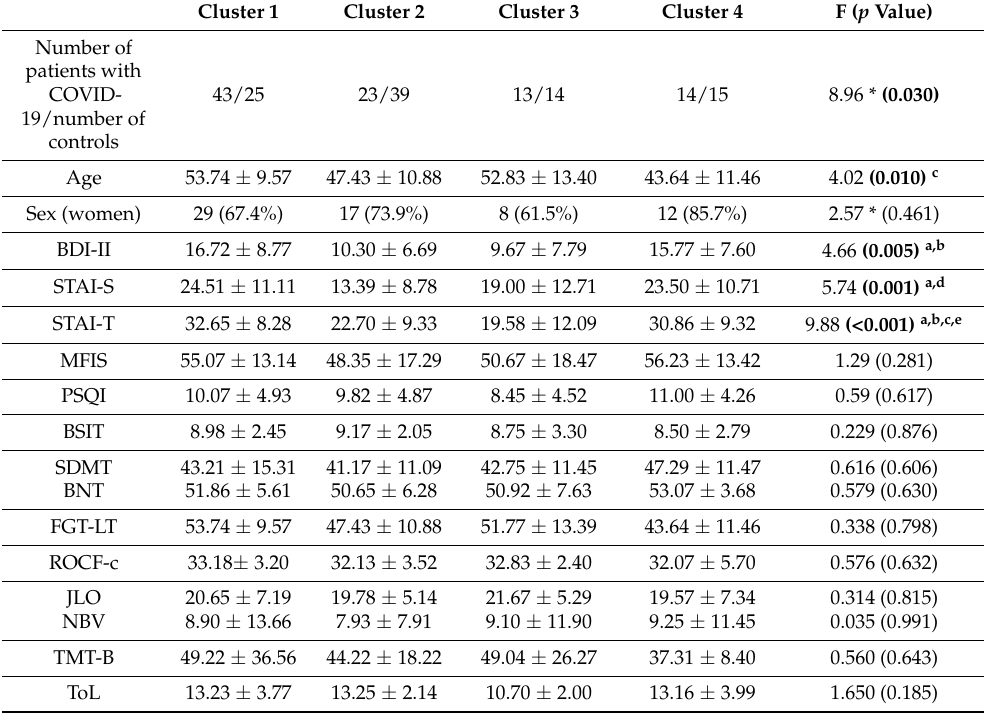
Figure 5. Distribution of Big Five personality traits between four clusters. Table 5. Neuropsychiatric characteristics of the four personality profiles derived from cluster anal- ysis.